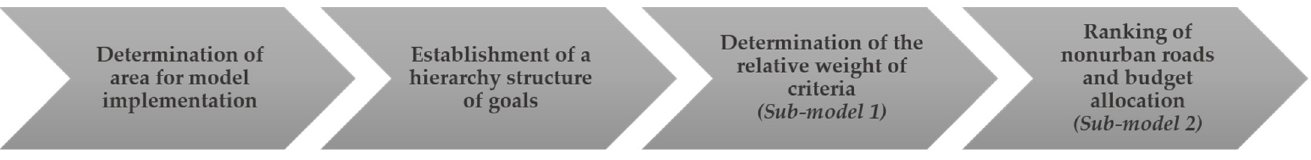
Figure 2. Summary view of planning process.